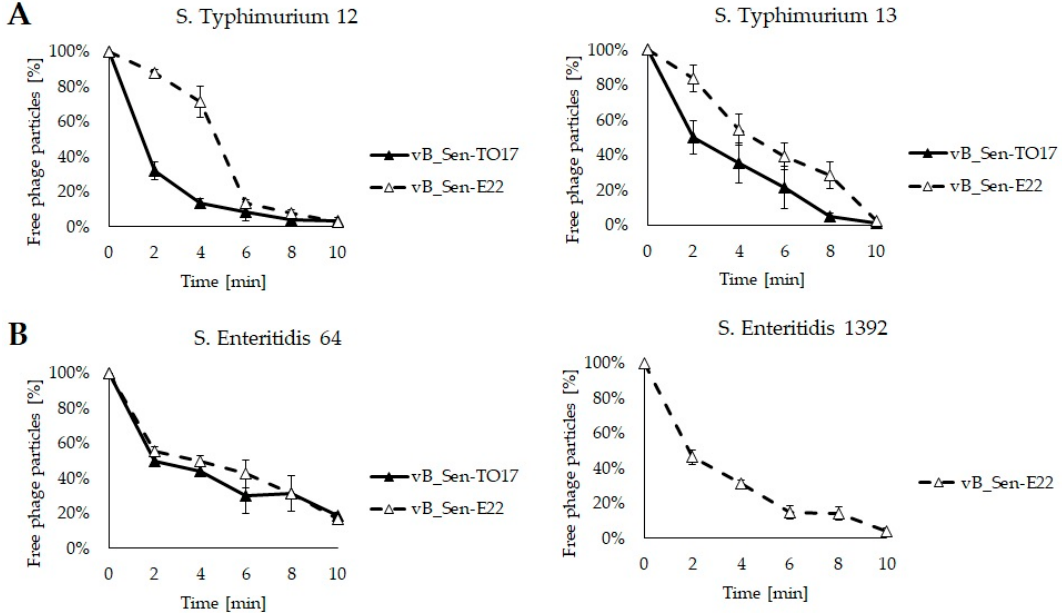
Figure 3. Adsorption rates of phages vB_Sen-TO17 (closed triangles) and vB_Sen-E22 (open triangles) on S. Typhimurium ( A ) and S. Enteritidis ( B ) at 42 °C. Number of free phage particles at time 0 was used as reference value (100%). Mean values from three independent experiments are shown, with error bars representing SD. Note that S. Enteritidis 1392 is resistant to vB_Sen-TO17 (Table 2); thus, experiments with this strain were performed only for vB_Sen-E22.